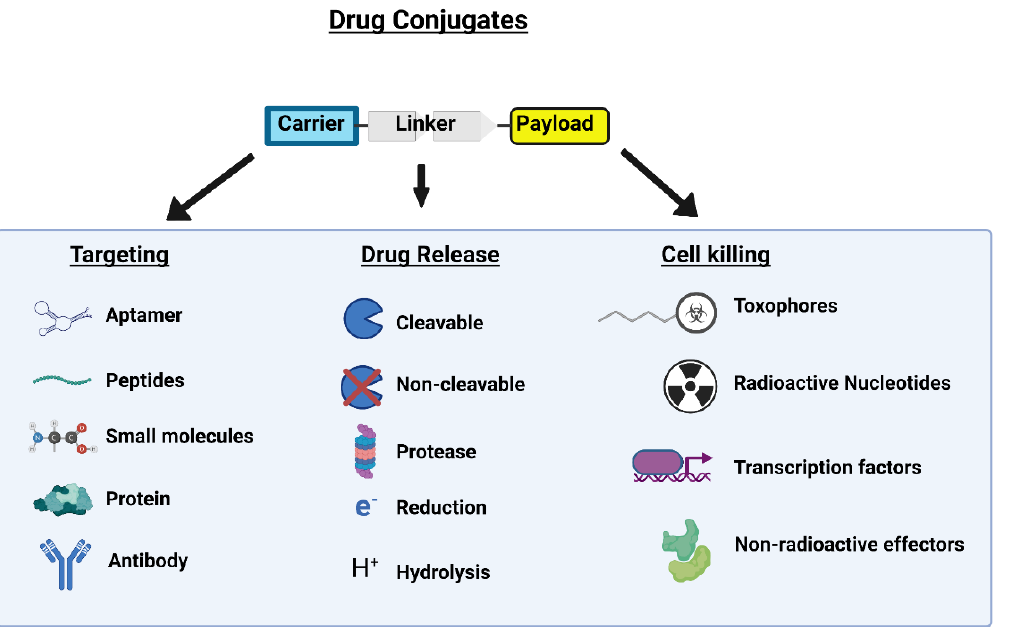
Figure 1. Drug conjugates are composed of 3 parts, carrier, linker and payload. The carrier, also referred to as homing peptides, targets and delivers the drug to the respective tumor target. The payload is the cytotoxin that kills the cancer cells, while the linker region bridges the two PDC com- ponents together and induces drug release. This figure was created using BioRender online App and license. and